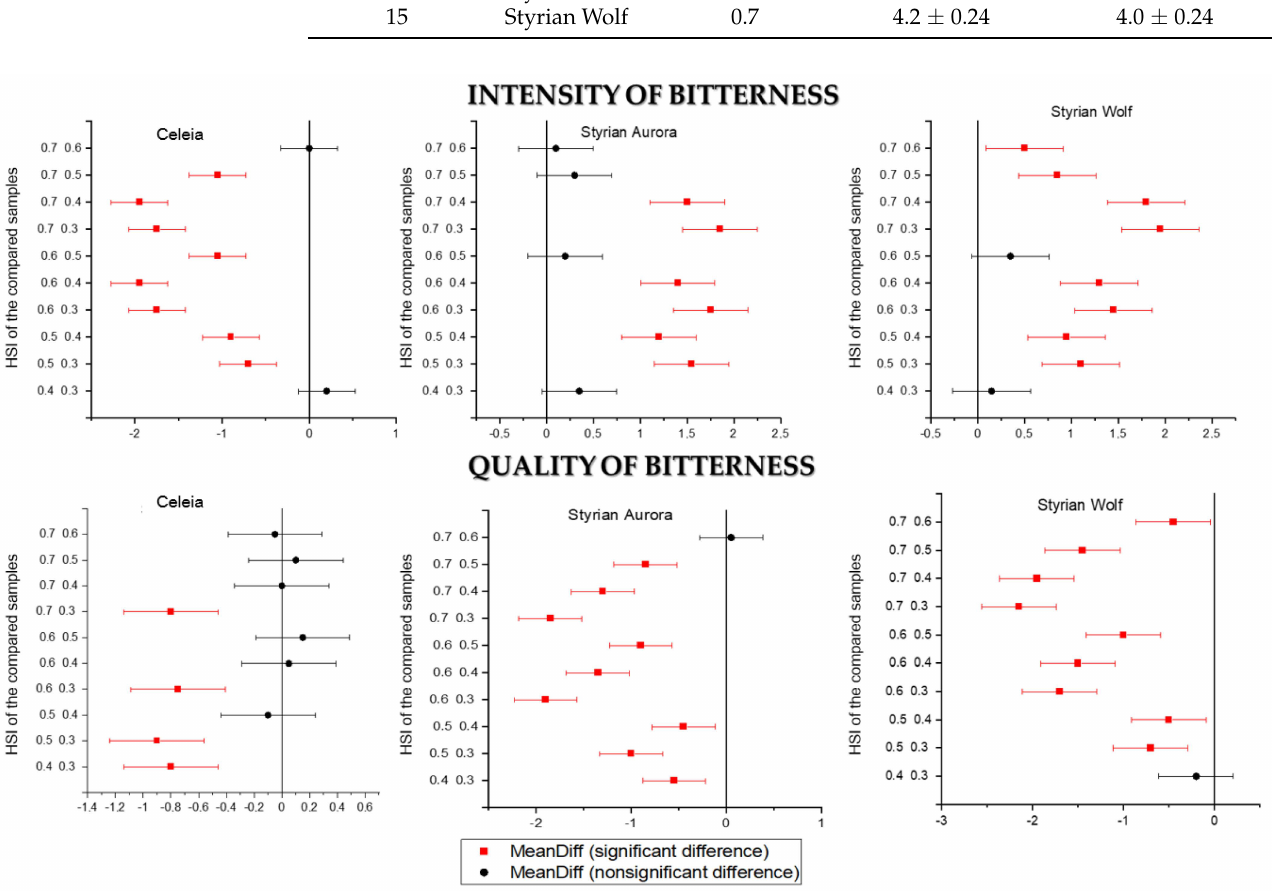
Figure 2. Tukey’s mean comparison plots for intensity and quality of